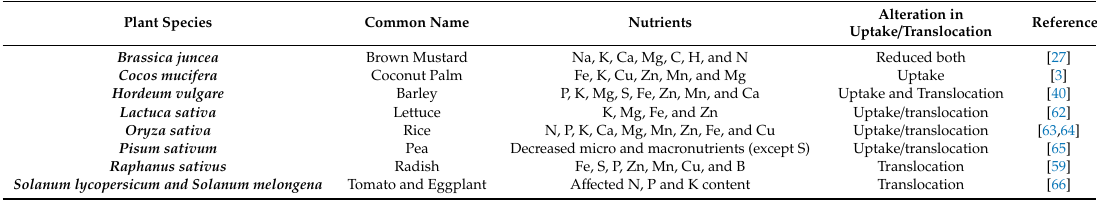
Table 6. Chromium-induced alteration in the uptake and translocation of the essential nutrients in various plant species.